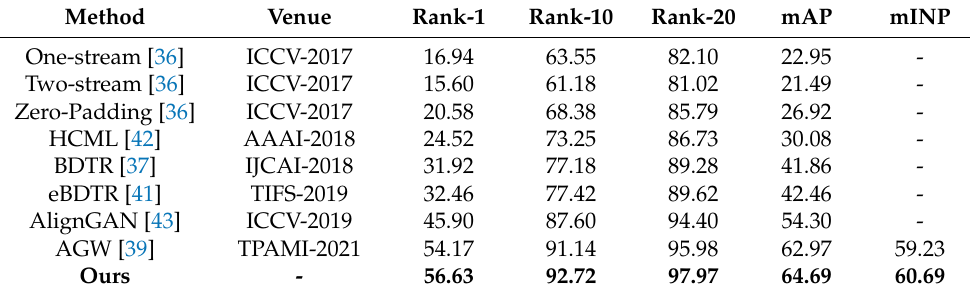
Table 2. Comparison of results in Indoor-Search mode.